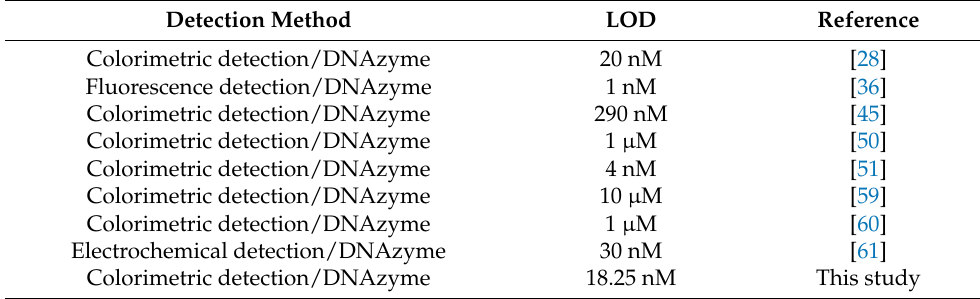
Table 3. Comparison of the LOD among different detection methods. Detection Method LOD